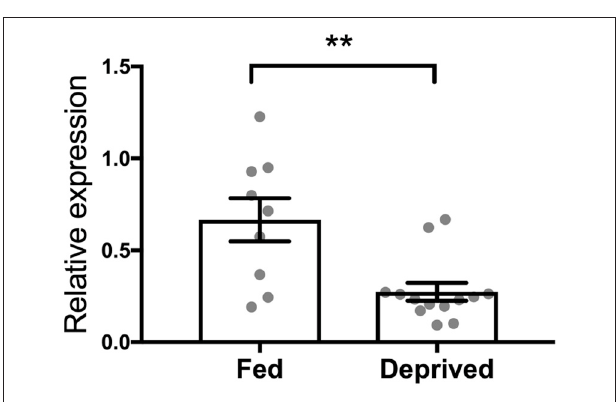
FIGURE 5 | Effect of 24-h food deprivation on expression of the OT receptor gene established with real-time PCR in the brain stem. Ad libitum-fed rats served as controls. ** p <